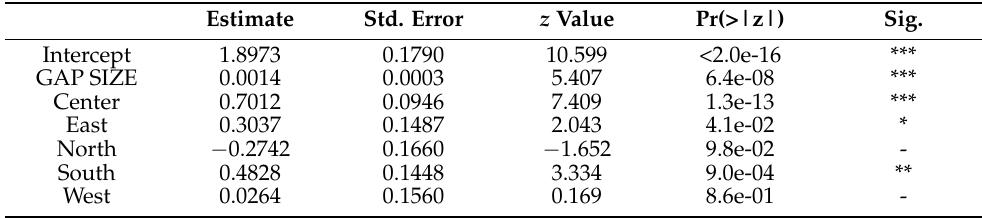
Table 3. Estimates of explanatory variables’ coefficients for the negative binomial generalized linear model (nbGLM) to evaluate the effect of predictor variables on seedling counts. NS, not significant; * p < 0.05; ** p < 0.01; *** p < 0.001.